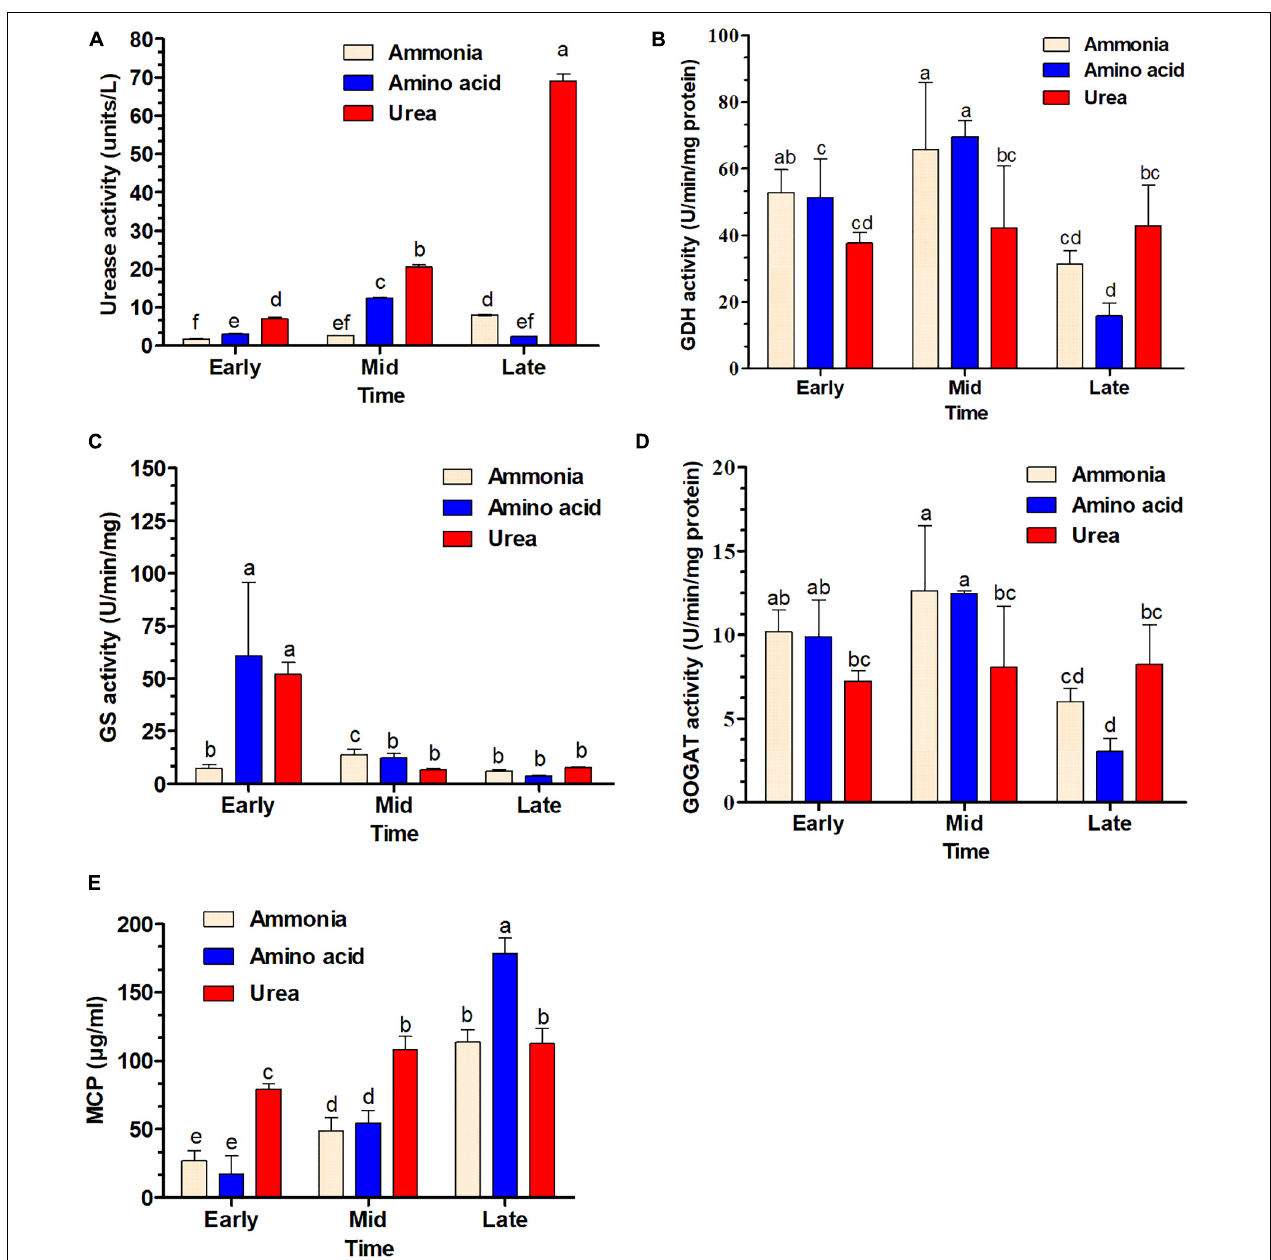
FIGURE 7 | Time course determination of enzyme activity and soluble microbial crude protein production (MCP) in S. dextrinosolvens Z6 grown on different nitrogen sources. The bars represent averages for triplicate cultures used to measure enzyme activity. Error bars represent standard deviations. (A) Urease